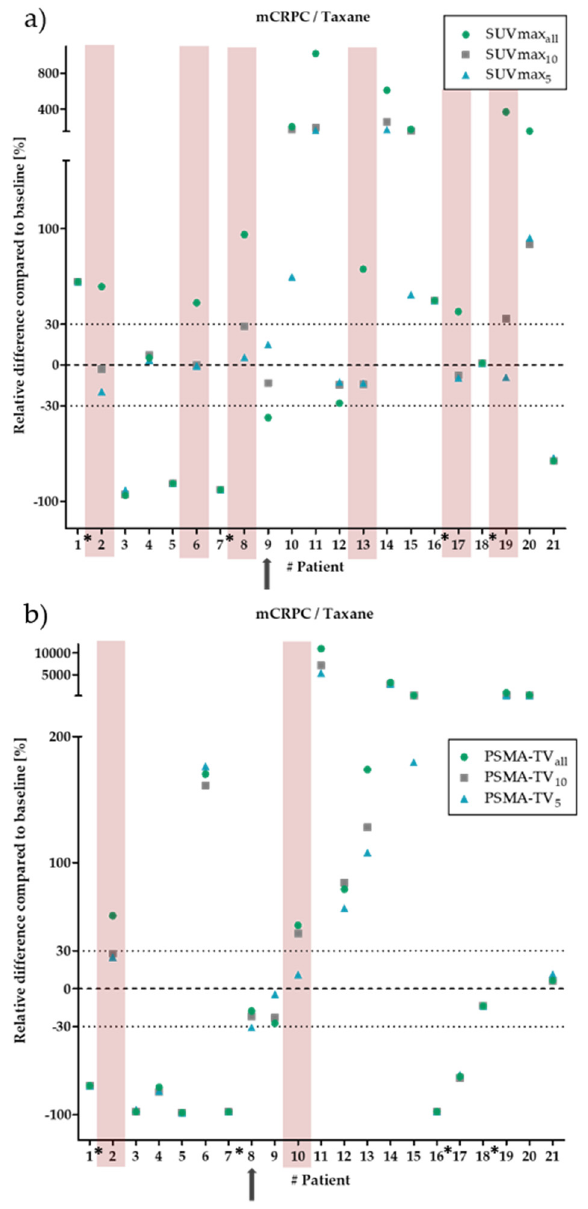
Figure 2. Relative changes between baseline and follow-up for SUV max ( a ) and PSMA-TV ( b ) in patients with metastatic castration-resistant prostate cancer (mCRPC) undergoing taxane therapy. The green dots show the changes for all segmented lesions. The grey squares/blue triangles show the ten/five hottest lesions for SUV max and the ten/five largest lesions for PSMA-TV. The dotted lines mark the borders, which are considered clinically relevant (±30%). The red bars mark patients with a clinically relevant deviation. For SUV max , 6 of the 21 patients showed a clinically relevant deviation. For PSMA-TV, 19 of the 21 patients showed no clinically relevant deviation. The black arrows indicate a clinically non-relevant deviation in one patient. The asterisks mark the patients with less than five lesions.